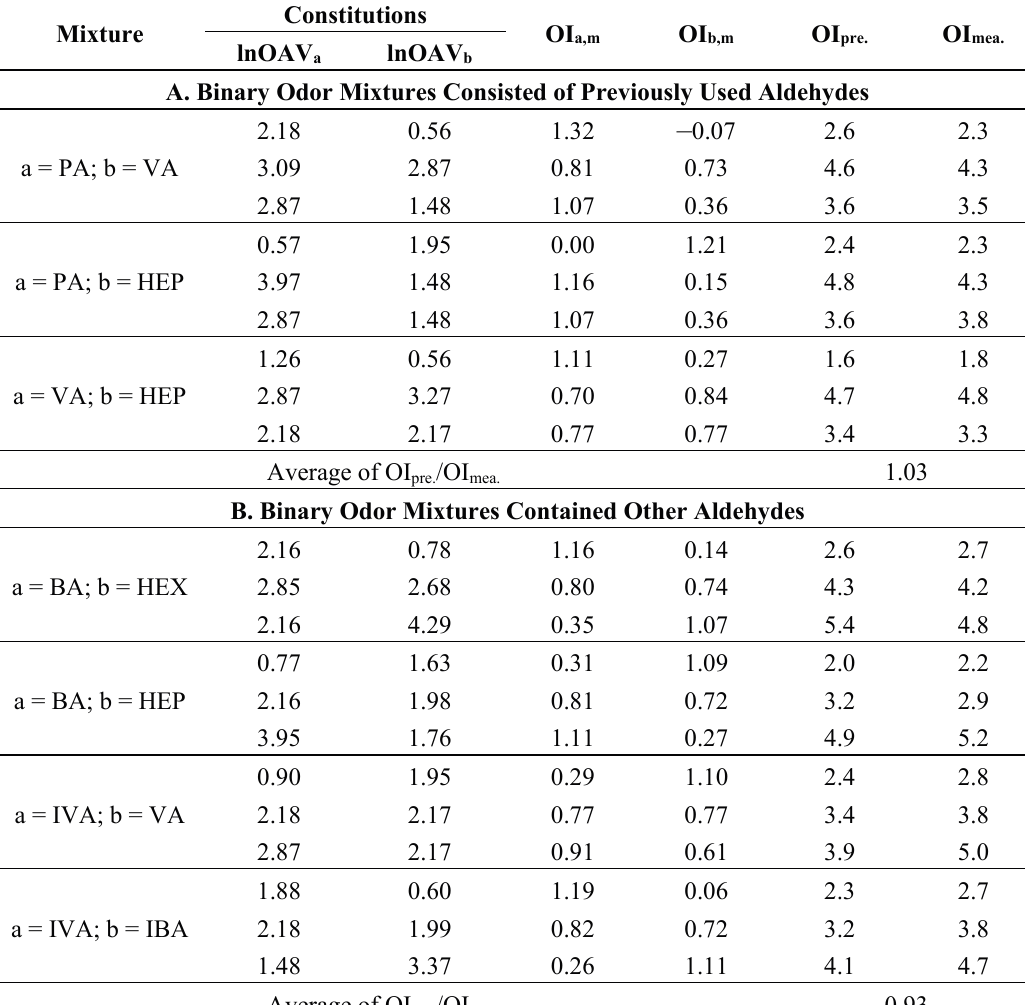
Table 2. Odor intensity predictive performance of the extended PDE model.